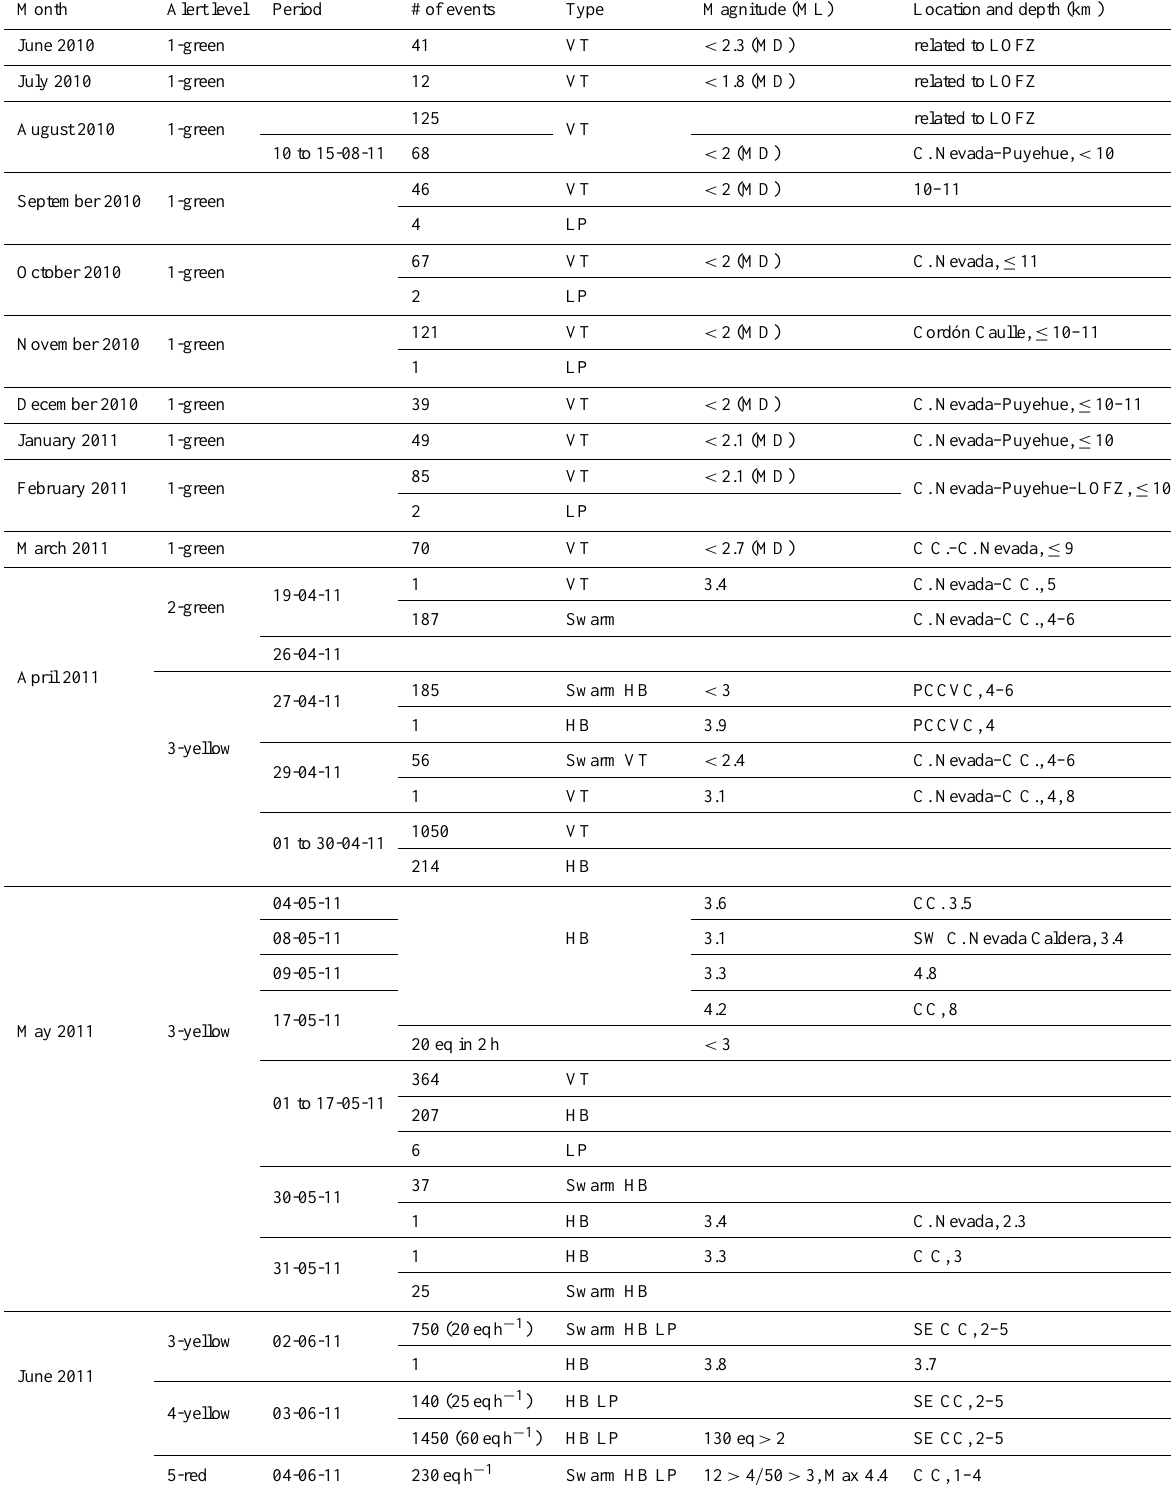
Table 1. Pre-eruptive activity of the PCCVC from June 2010 to June 2011. The table includes alert level and type, number and location of earthquakes. Magnitude corresponds to ML: local magnitude, except indication in brackets which corresponds to MD: duration magnitude; eqh − 1 : earthquakes per hour; VT: volcano tectonic; LP: long period; HB: hybrid; LOFZ: Liquiñe–Ofqui fault zone, CC: Cordón Caulle. Taken from SERNAGEOMIN-OVDAS,